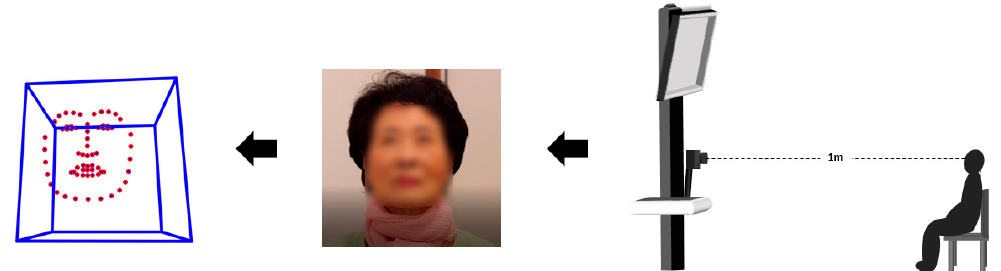
Figure 1. Example of the experimental environment.